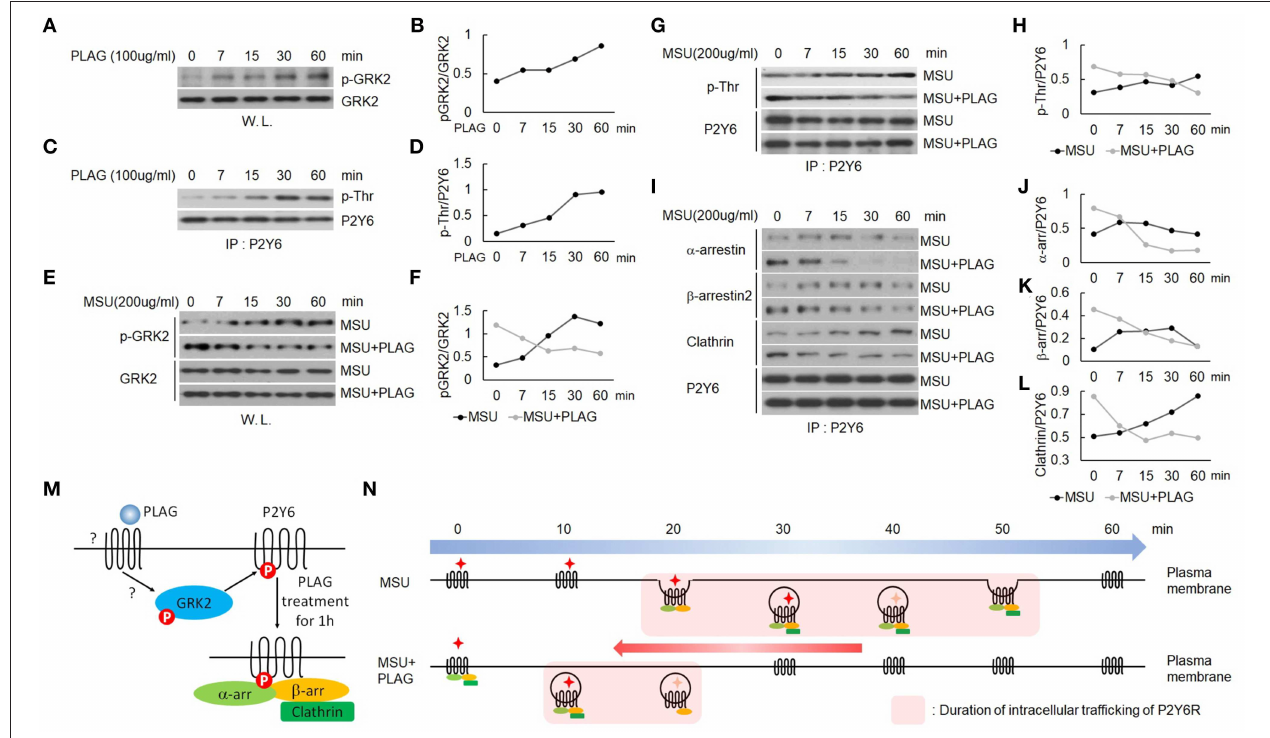
FIGURE 5 | PLAG phosphorylates GRK2 and P2Y6 receptor to form a receptor endocytosis-related protein complex. (A) Effect of PLAG on phosphorylation of GRK2. THP-1 cells were treated with 100 µ g/ml PLAG for 0, 7, 15, 30, and 60min. Whole lysates were used to analyze phosphorylated GRK2 and total protein of GRK2. (B) Quantification of (A) . (C) Effect of PLAG on phosphorylation of P2Y6 receptor. Cell lysates were immunoblotted with phospho-threonine antibody after immunoprecipitation with the P2Y6 receptor antibody. (D) Quantification of (C) . (E) THP-1 cells were incubated with 100 µ g/ml PLAG for 1h and then were stimulated with 200 µ g/ml MSU crystals for 0, 7, 15, 30, and 60min. Whole lysates were used to analyze phosphorylated GRK2 and total protein of GRK2. (F) Quantification of (E) . (G) Cell lysates were immunoblotted with phospho-threonine antibody after immunoprecipitation with the P2Y6 receptor antibody. (H) Quantification of (G) . (I)